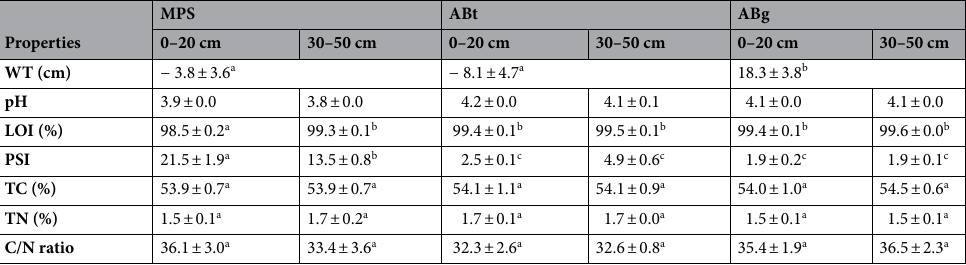
Table 1. Peat soil physicochemical properties of MPS, ABt, and ABg at 0–20 cm and 30–50 cm soil depths. Values are mean ± standard error. Different letters in the same row indicate significant difference at the level of P < 0.05 based on Tukey’s HSD test. WT water table with (−) values indicating depths below soil surface, LOI loss-on-ignition, PSI pyrophosphate solubility index, TC total carbon, TN total nitrogen.